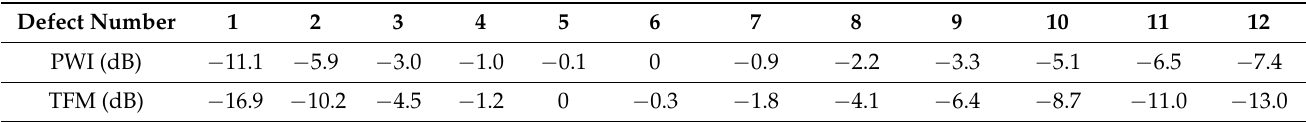
Table 2. Attenuation introduced at each defect in the simulation.